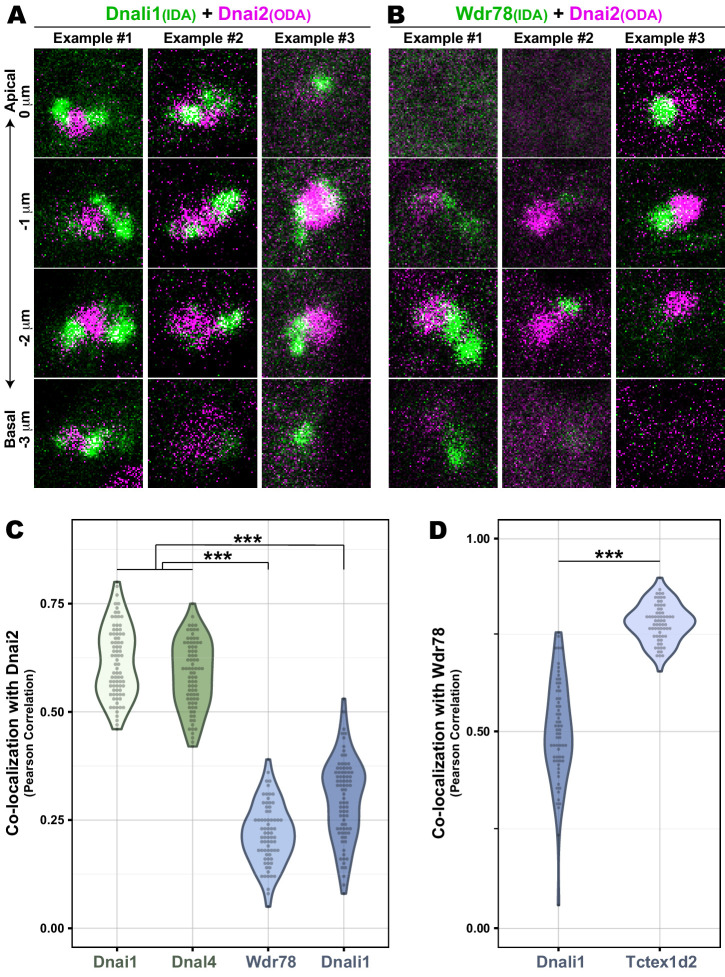
Co-localization data for IDAs and ODAs in DynAPs.(A) En face optical Z-sections through DynAPs possessing GFP-Dnali1 and mCherry-Dnai2. (B) En face optical Z-sections through DynAPs possessing GFP-Wdr78 and mCherry-Dnai2. (C) Graph displaying Pearson correlation for colocalizations of GFP fusion dynein subunits, Dnai1 (n = 82), Dnal4 (n = 83), Wdr78 (n = 73) and Dnali1 (n = 83), with mCherry-Dnai2 at DynAPs. p-value (***)<0.0000001 by one-way ANOVA and post-hoc Tukey-Kramer HSD test. (D) Graph displaying Pearson correlation for colocalization of two different IDA subunits, GFP-Dnali1 (n = 65) and GFP-Tctex1d2 (n = 67) with mCherry-Wdr78 at DynAPs. p-value (***)<2.2e-16 by Welch Two Sample t-test.